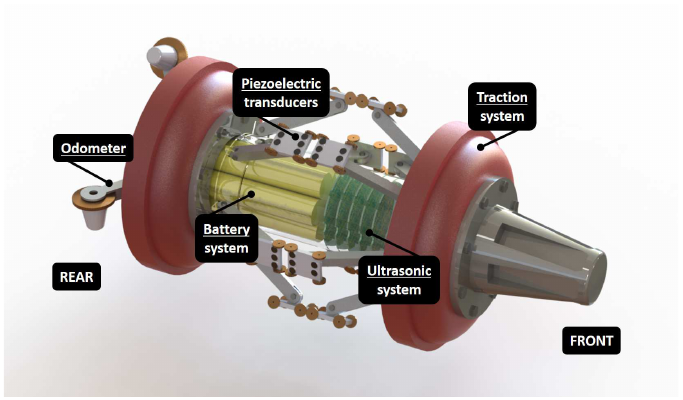
Figure 1. Pipeline inspection gauge (PIG) in development for automatic pipeline